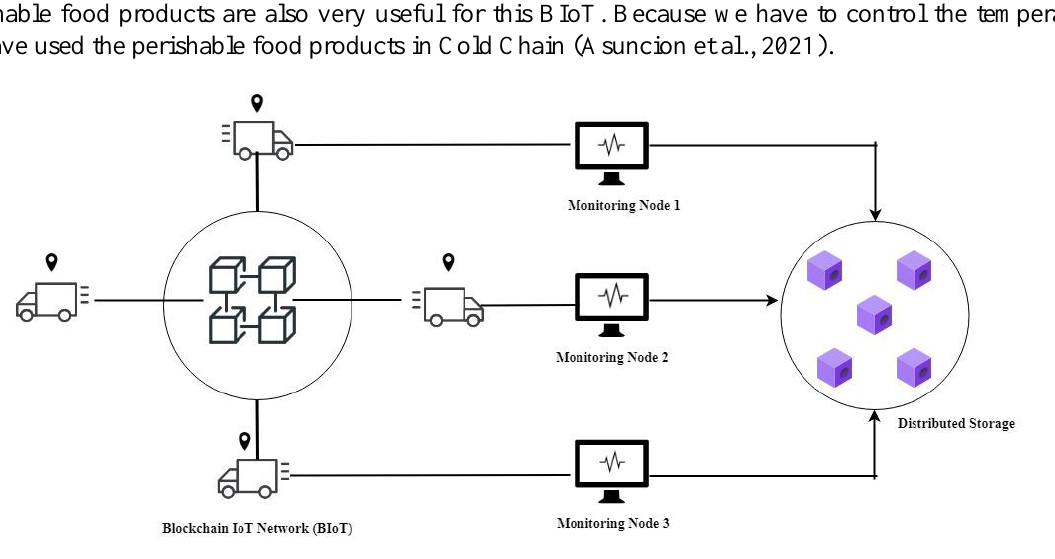
Figure 15. Food monitoring framework using